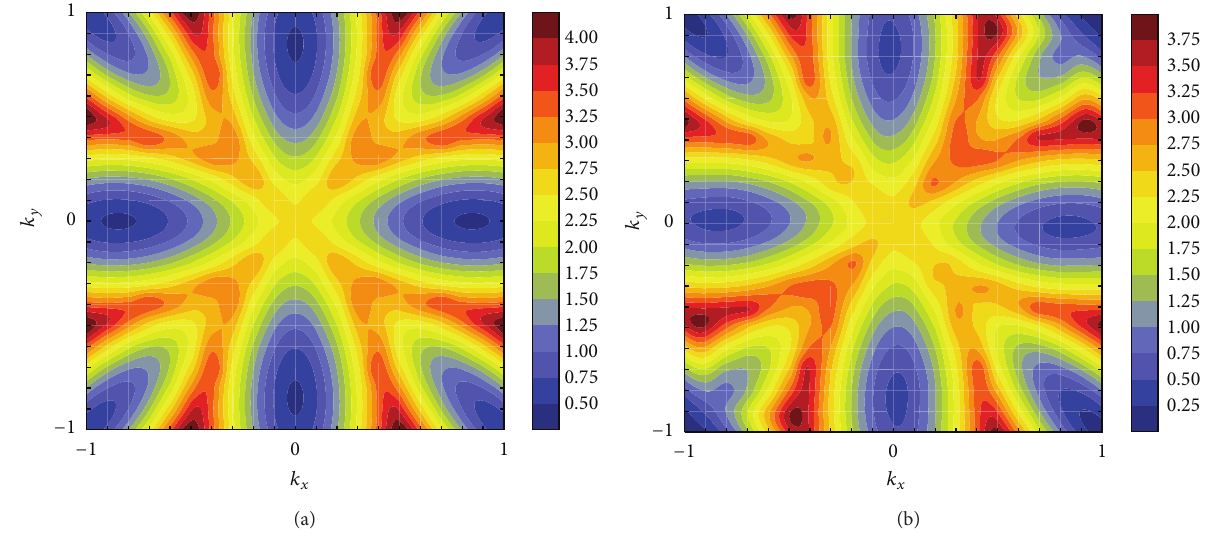
Figure4:Contourplotof 𝜖 𝑛 k inthe 𝑘 𝑧 = 0 planeoftheBrillouinzoneforthelowestconductionbandwithoutstrain(a)andwith3.0%uniaxial strain in the [110] direction (b). The quasiparticle energies are given in eV and relative to the minimum of the band in each configuration.